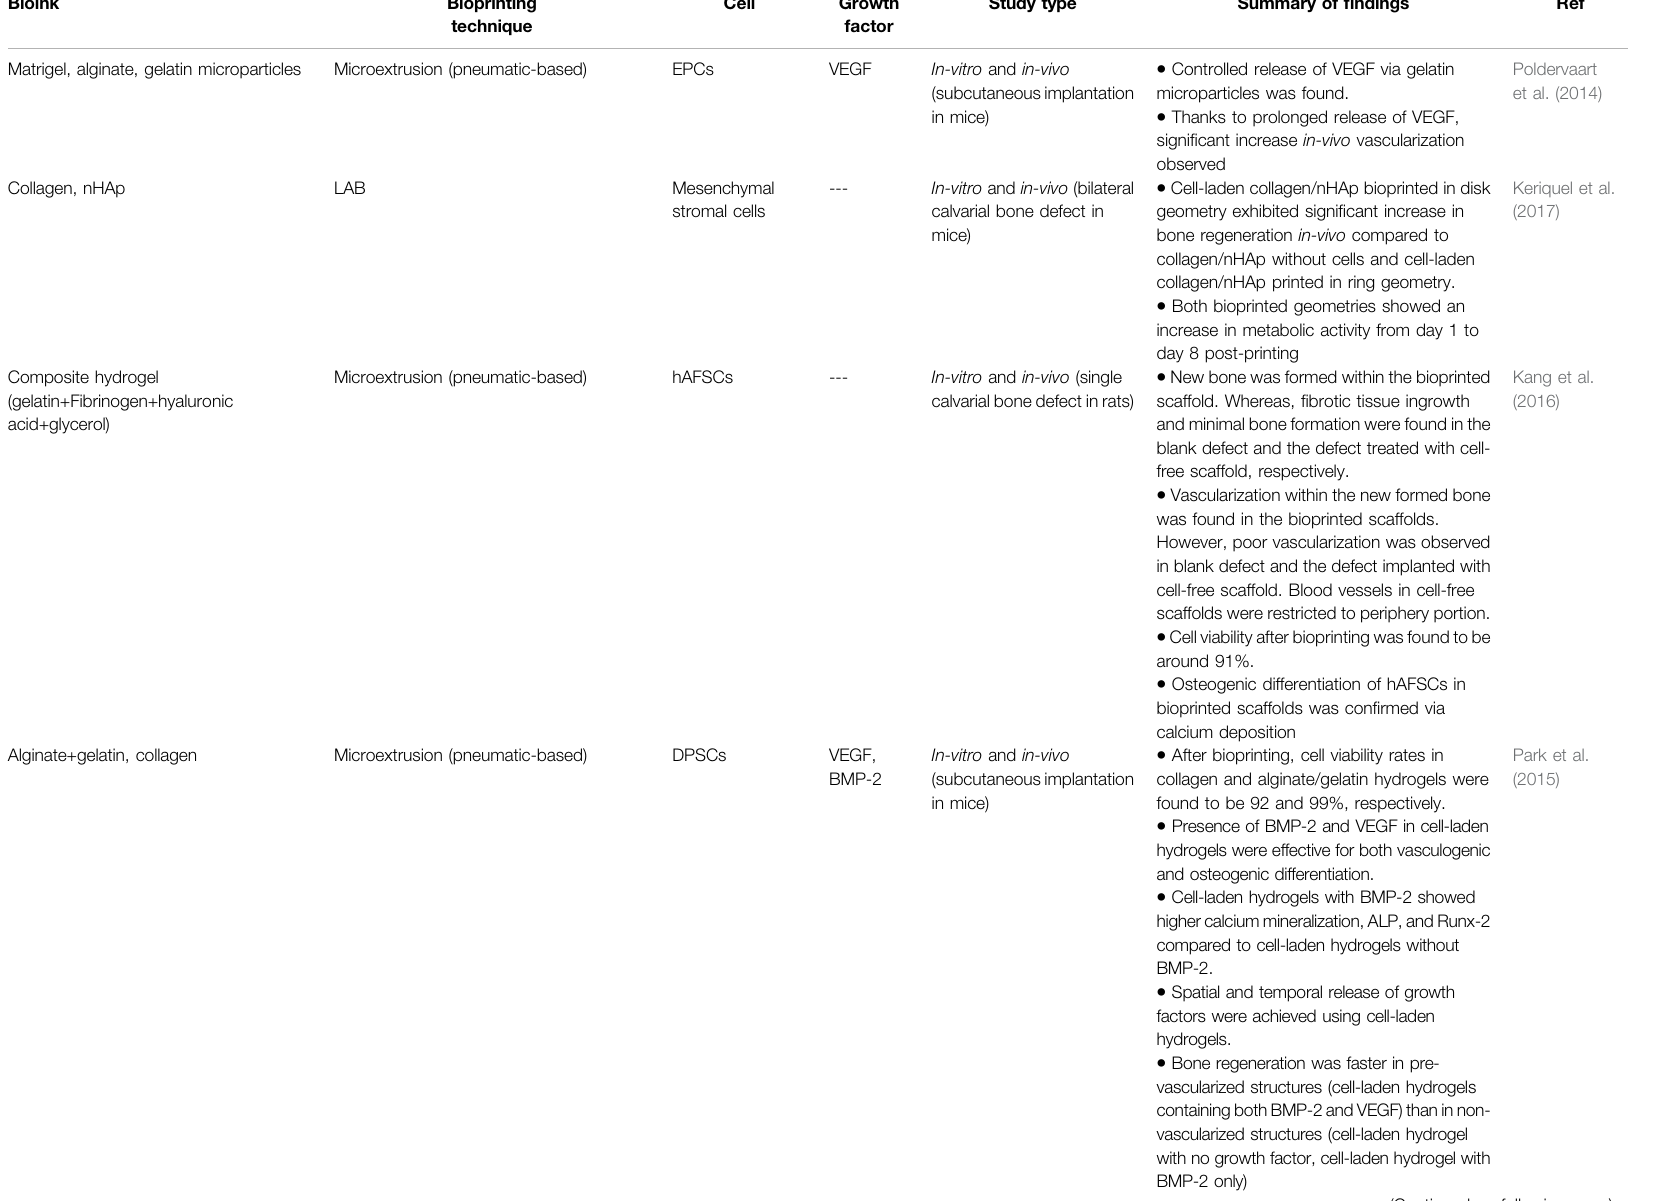
TABLE 4 | Tracking bone regeneration using bioprinted